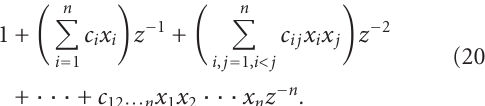
is (1,1). Considering (17) as a map from ( x 1 , x 2 ) space